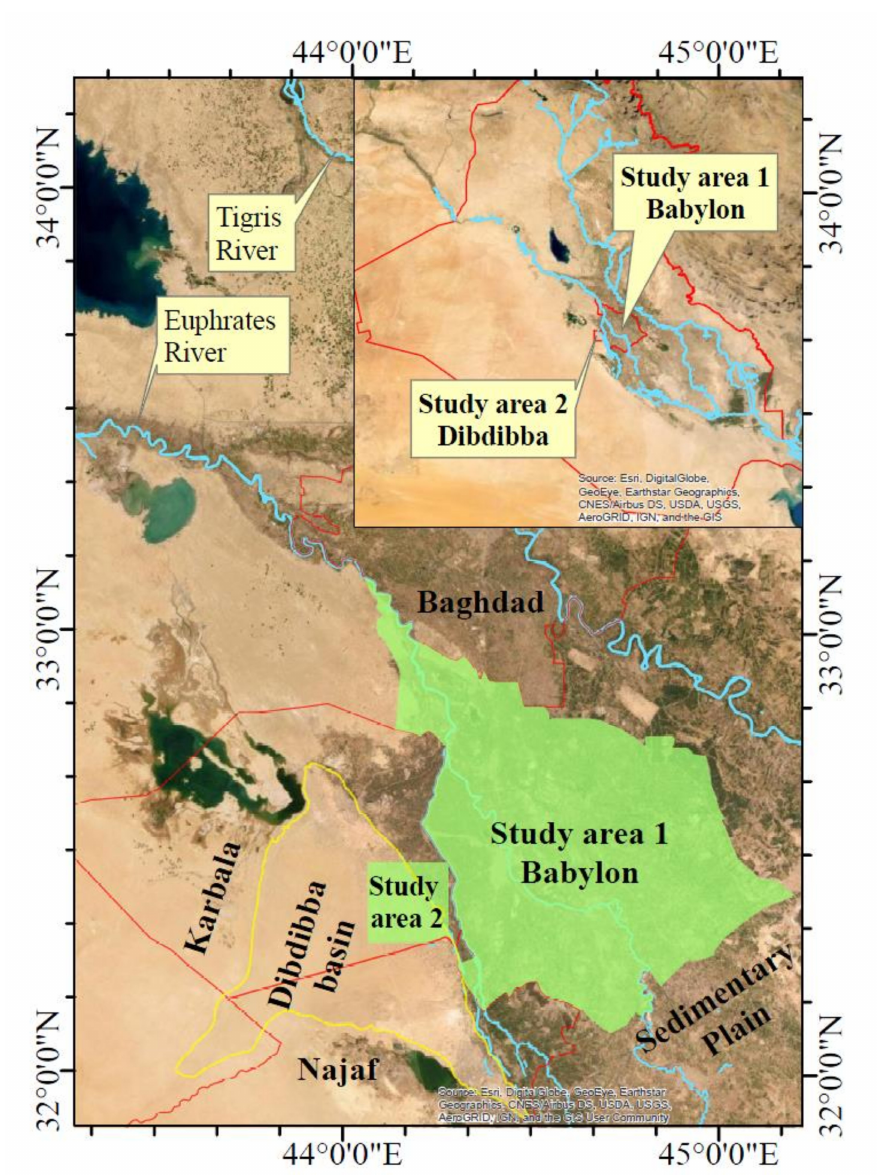
Figure 1. Study area (Babylon and Dibdibba aquifers within Iraq) projected on satellite images [109]. 2.1.